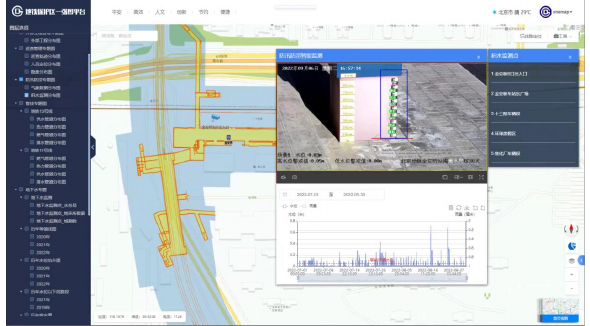
Figure 10 . Thematic map of flood control and waterlogging prevention monitoring.